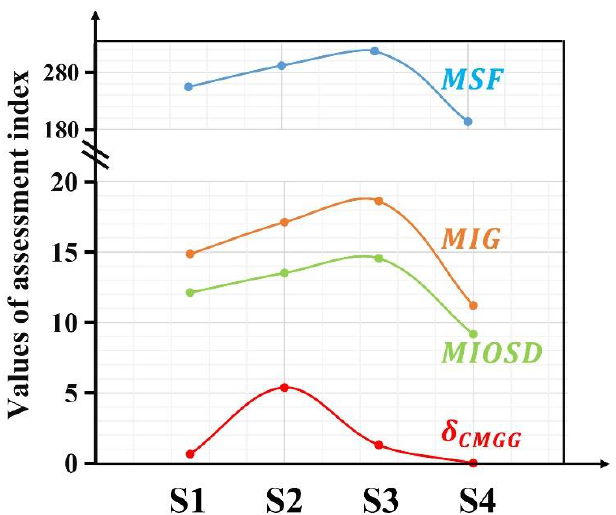
Figure 12. Comparison of different assessment criteria.